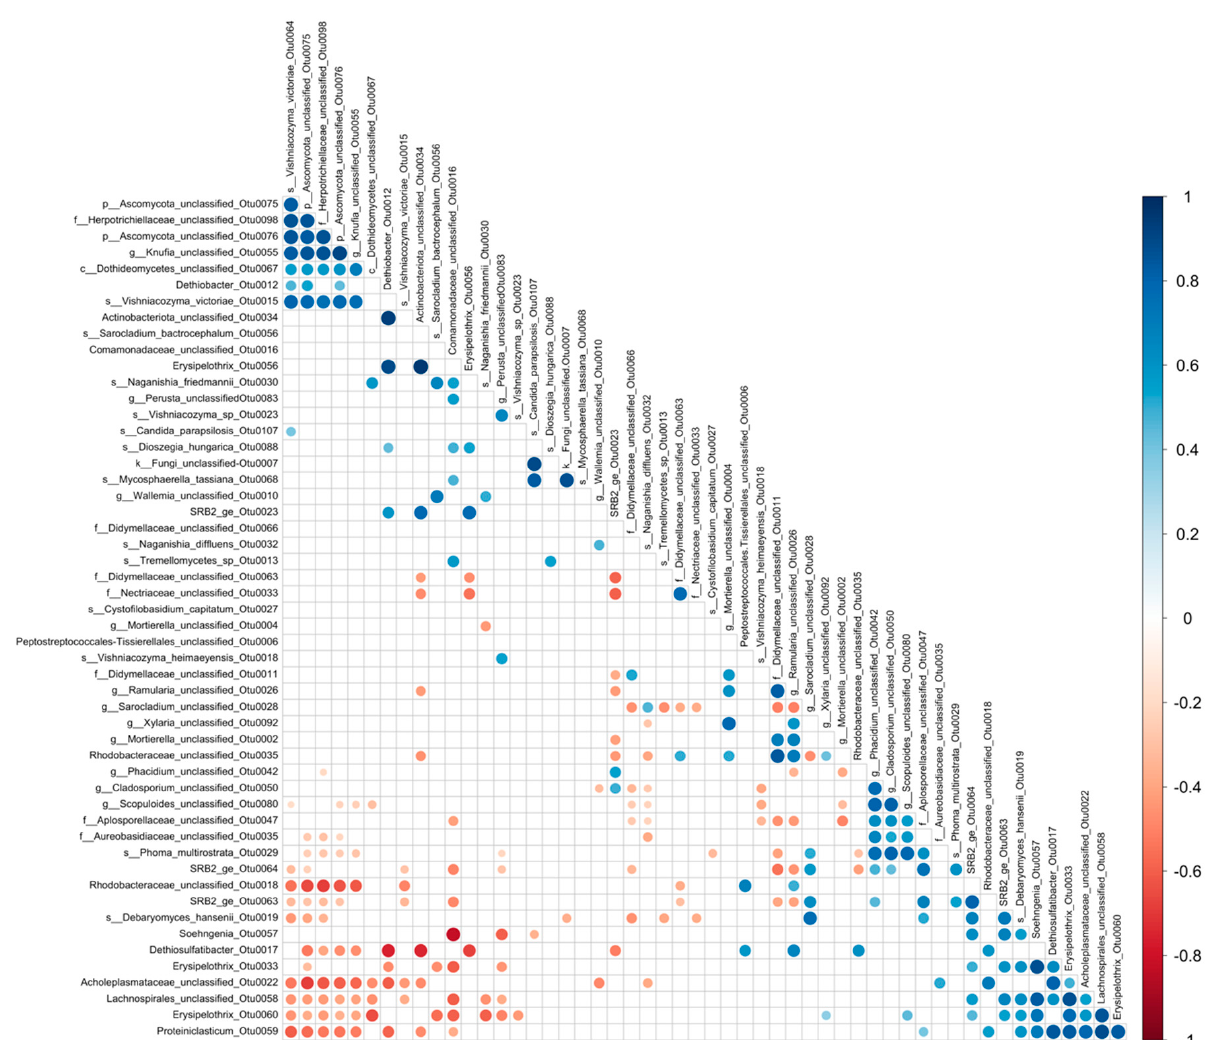
Figure 13. Cross-kingdom SPARCC correlations detected in the data. Only significant ( p < 0.05) correlations between fungal and bacterial OTUs present in at least two samples (rock surface samples) with minimum 50 fungal sequence reads, or 20 bacterial sequence reads are shown. Blue color indicates positive correlations and red color negative correlations. The color scale on the right indicate the level of the correlation, with darker color for the strongest positive or negative correlations. In the taxon names, p, f, g, c, and s prefixes indicate identification to phylum, family, genus, class, or species level, respectively.